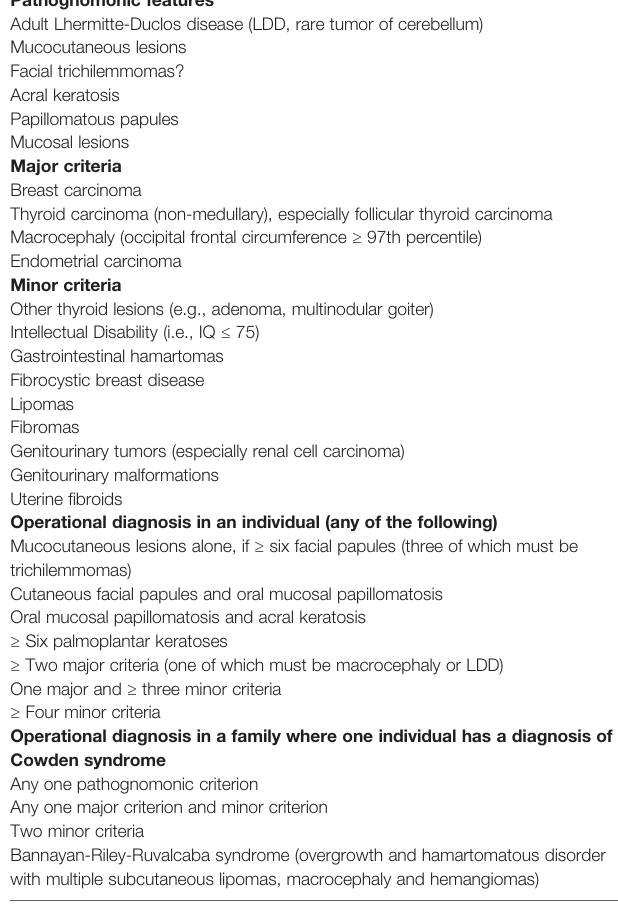
TABLE 3 | Tuberous sclerosis complex diagnostic criteria. Adapted from (22). Genetic diagnostic criteria